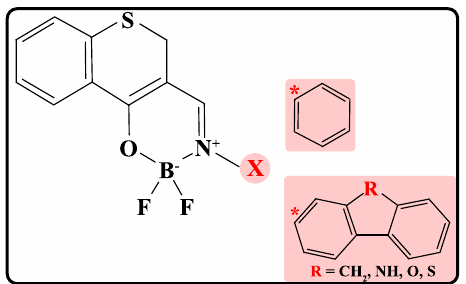
Figure 4. Designed molecules based on S-BF2. The pink part shows the